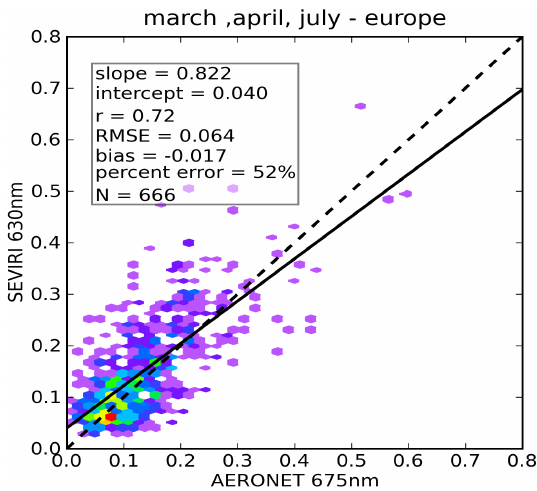
Fig. 10. Density graph of the daily SEVIRI and AERONET AOT at 0.6µm for European stations for the 3 months of interest (March, April and July 2006). The linear regression is plotted and the results of this regression are indicated on the graph.